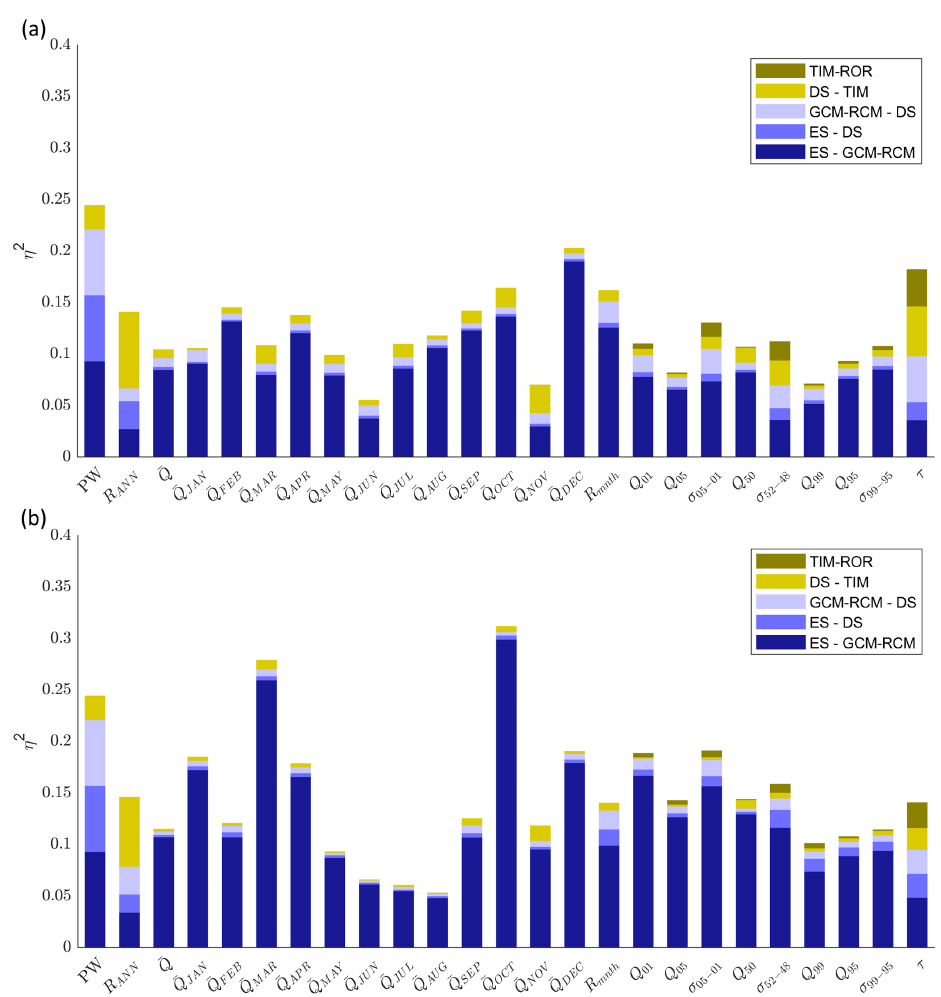
Figure 14. Effect size ( η 2 ) of the five most significant interactions on projected changes in the 25 river discharge signatures at the start (2030s, a ) and end (2080s, b ) of the 21st